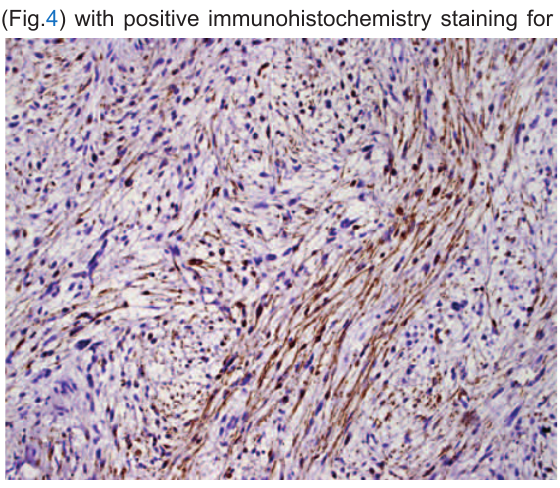
Figure 5. Tumor cells with positive immunohistochemistry staining for desmin (zoom x 200).